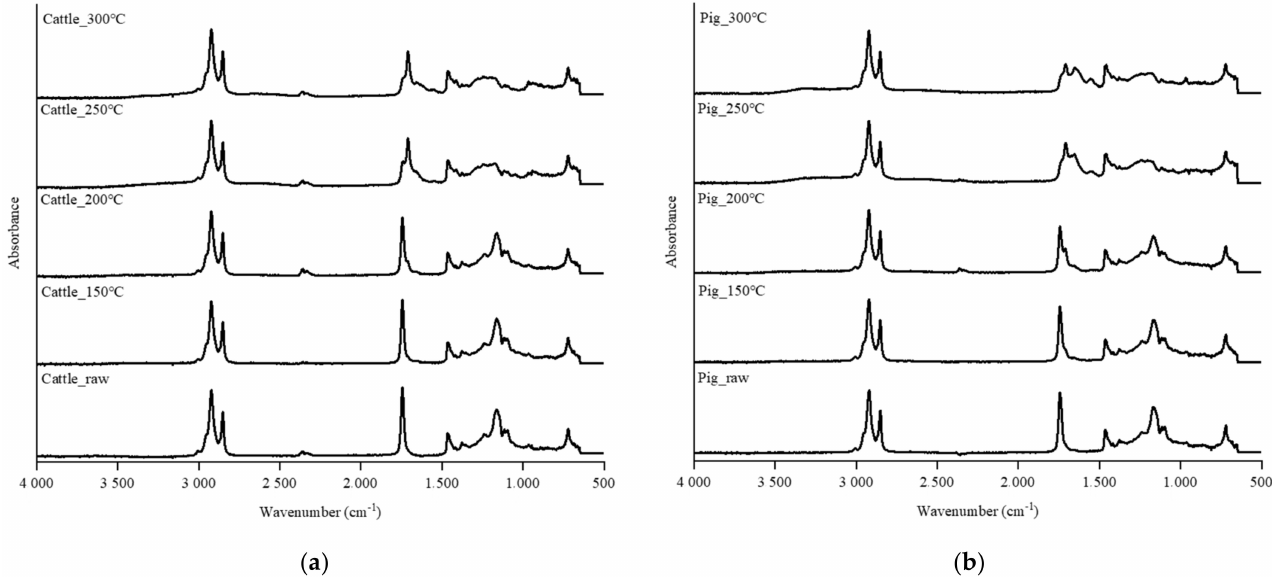
Figure 5. Fourier transform infrared (FTIR) spectra of the raw SHWs and hydrochars for ( a ) cattle and ( b )